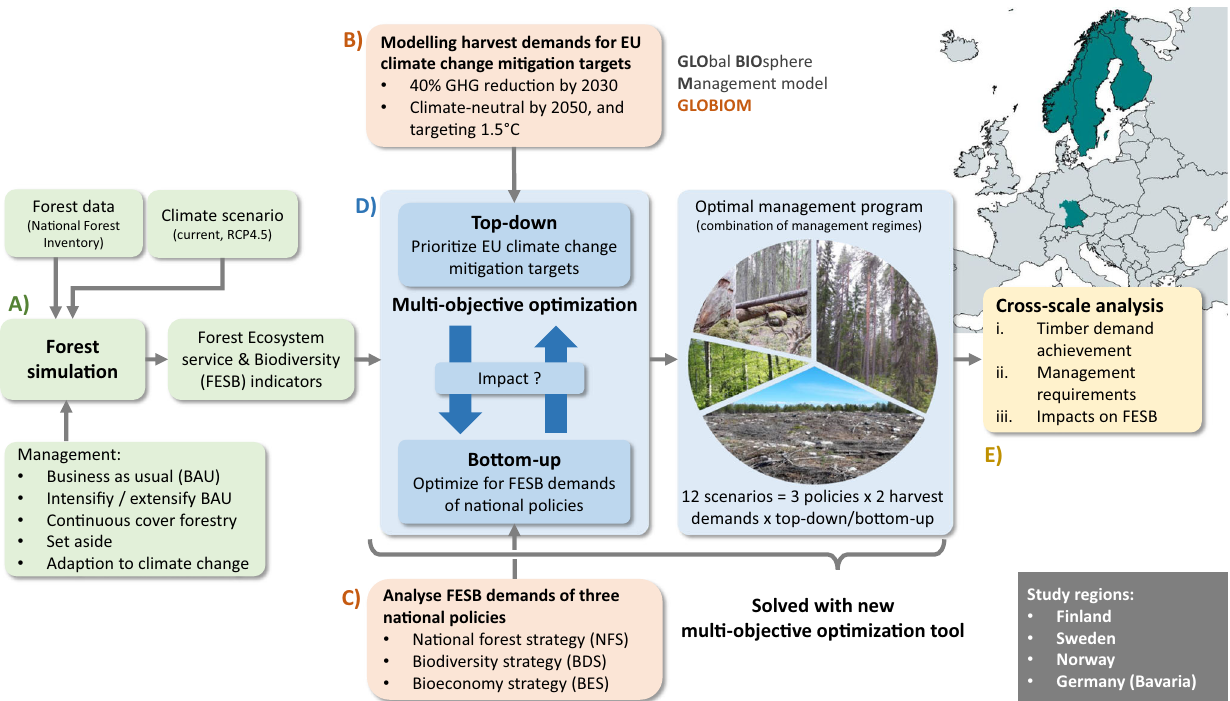
Fig. 1 Data and work fl ow of the study identically implemented in four European study regions. This included: A) empirical forest dynamics and management simulations to obtain future potentials of forest ecosystem services and biodiversity (FESB) indicators under alternative climate pathways, B) modeling future harvest demand scenarios for EU climate change mitigation policies, C) analyzing national policies for FESB demands, D) optimizing forest management for FESB demands representing national forest policy domains (bottom-up approach), and by prioritizing harvest demands representing EU mitigation targets above national policy domains during the multi-objective optimization (top-down approach), and E) a cross-scale analysis between the EU-level perspective versus the national-level perspective based on the optimized forest management outcomes and its consequences for FESB.